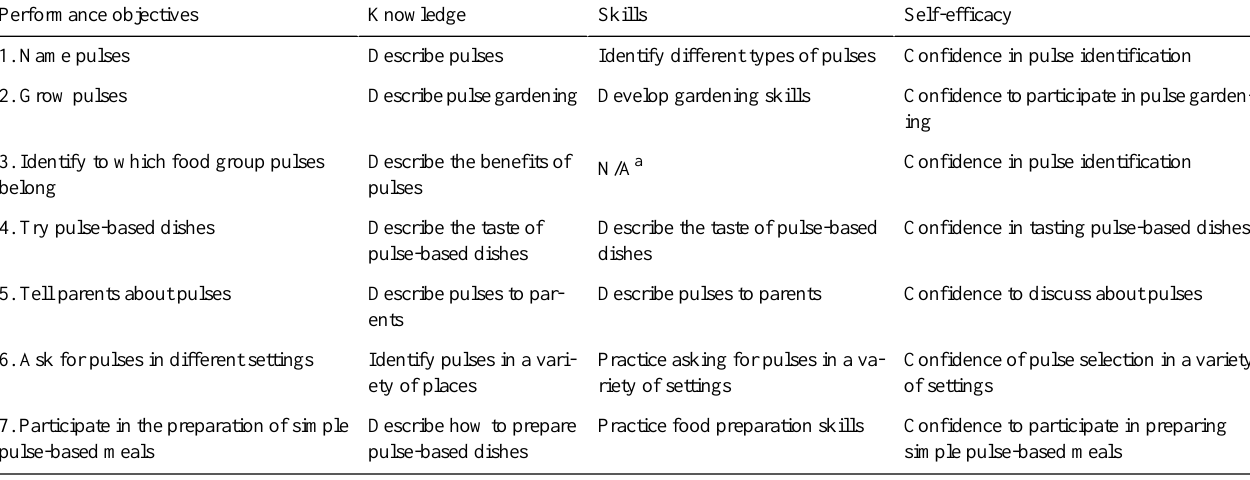
Table 1. A matrix of performance objectives for preschool children in the Pulse Discovery Toolkit intervention.